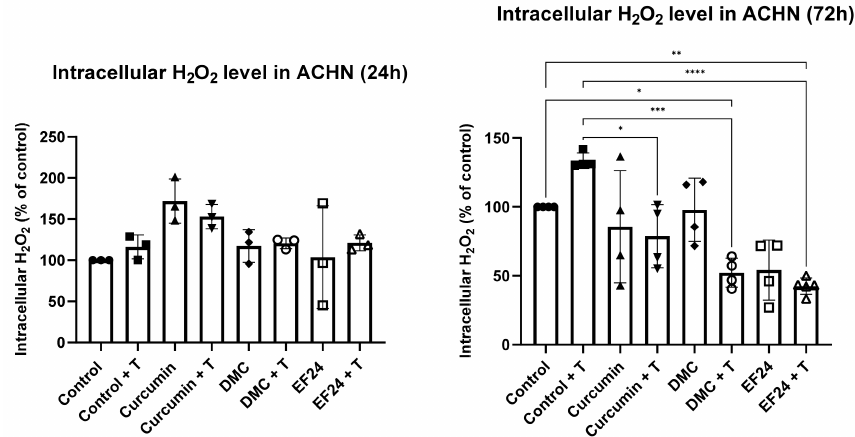
Treatment with curcumin, DMC or EF24 individually or in combination with TRAIL also had an effect on the intracellular levels of H 2 O 2 over time. Intracellular H 2 O 2 was initially increased after 24 h treatment in ACHN cells treated with curcumin and curcumin + TRAIL, and slightly increased in samples treated with DMC (individually and in combi- nation with TRAIL) and EF24 + TRAIL (see Figure 4). Intracellular H 2 O 2 was significantly reduced following 72 h treatment with curcumin + T (78.77% compared to control + T), DMC + T (52.18% compared to control) and EF24 + T (42.50% compared to control).